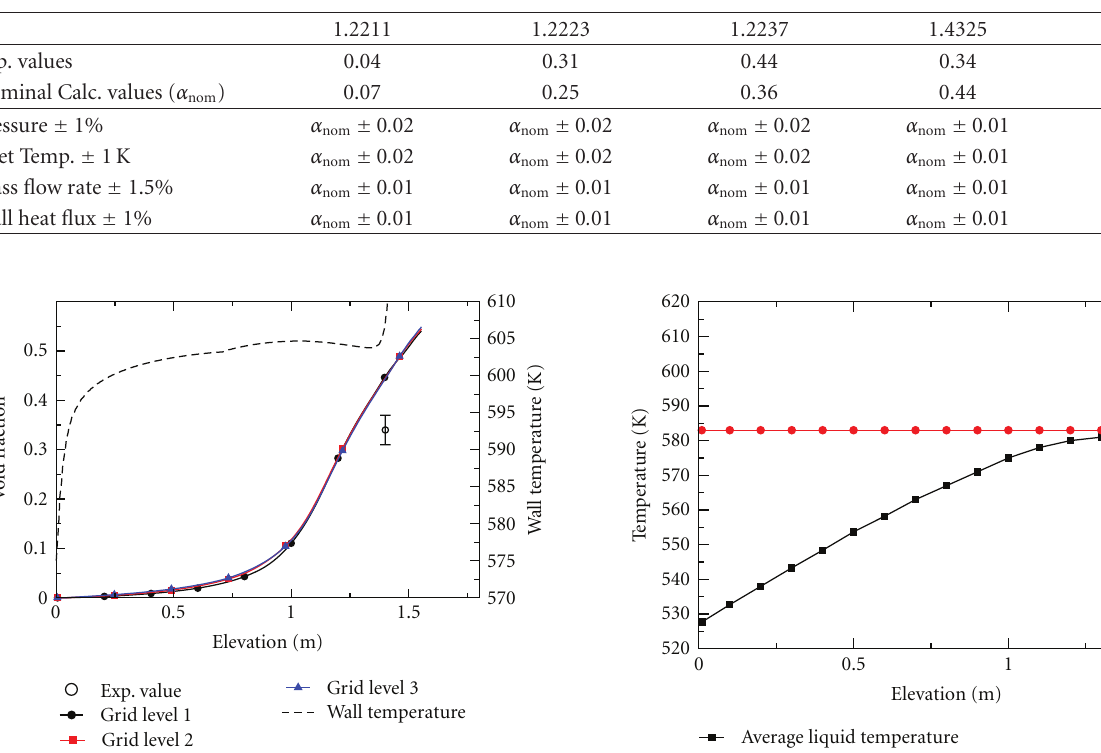
Table 5: E ff ect of the experimental uncertainties on the calculated void fraction.